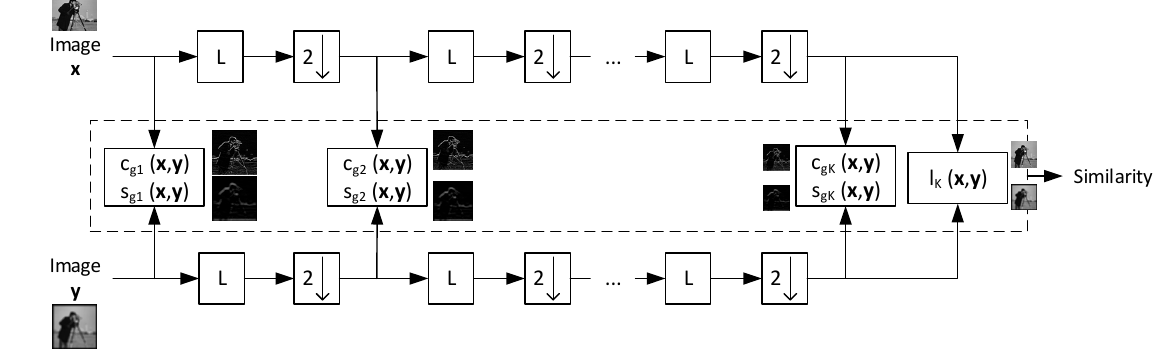
Figure 5. MS-GSSIM procedures to quantify the image quality. 𝐿 is low-pass filtering and 2 ↓ denotes downsampling by 2 .